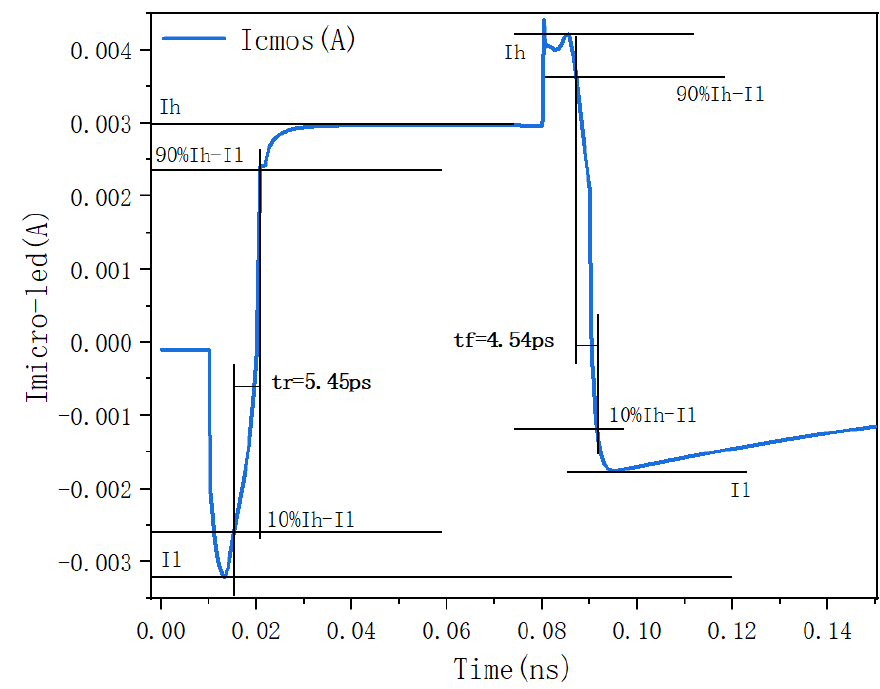
Figure 15. Analysis of rising time and falling time of the output current curve of the micro-LED directly driven by the CMOS inverter with time.